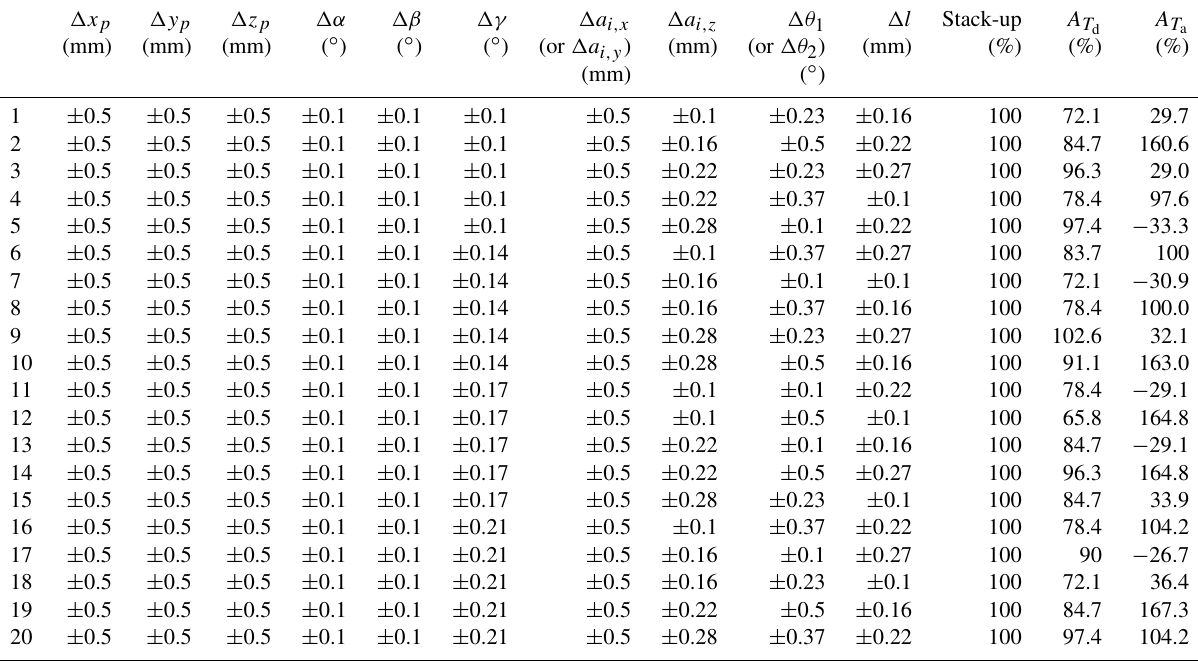
Table 10. Array U 20 (4 4 ) for responses with a sample size of 10 5 using Halton-set based MC simulation (part A).